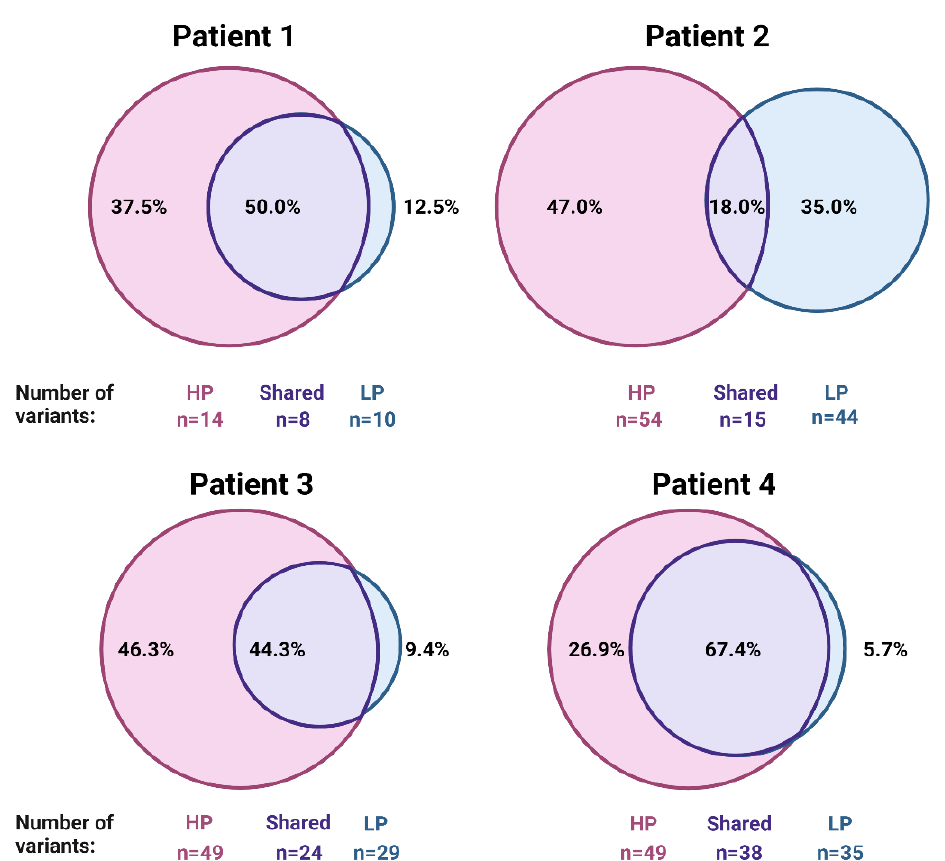
Figure 4. Variants detected in compartments with higher proliferation constitute the majority of variants detected in melanoma tumors. Numbers and percentages of variants detected in high proliferation (HP), low proliferation (LP), and in both compartments (shared).